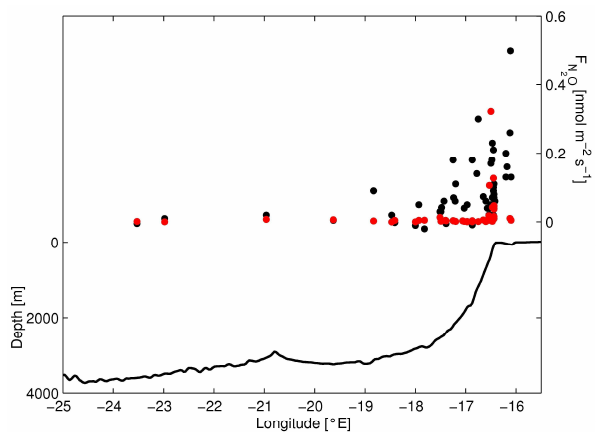
Fig. 4. 1 N 2 O vs. SST anomaly. The black line denotes the lin- ear regression of 1 N 2 O with respect to the SST anomaly for SST anomalies smaller than